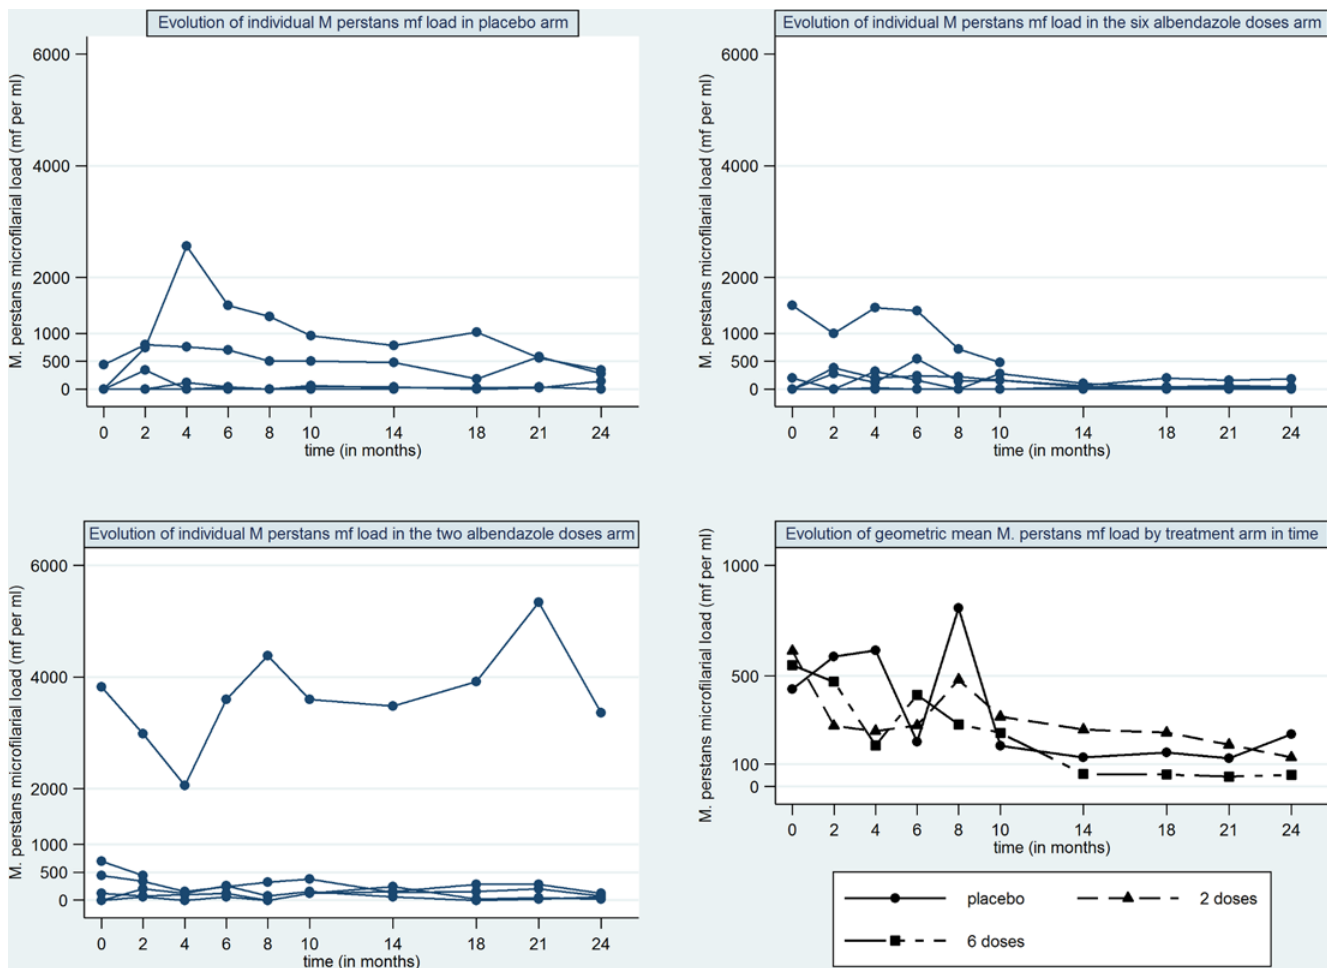
Fig 4. M . perstans microfilariae levels in participants in whom M . perstans was detectable at least once during the study by treatment group. mf per ml: microfilaria per millilitre of